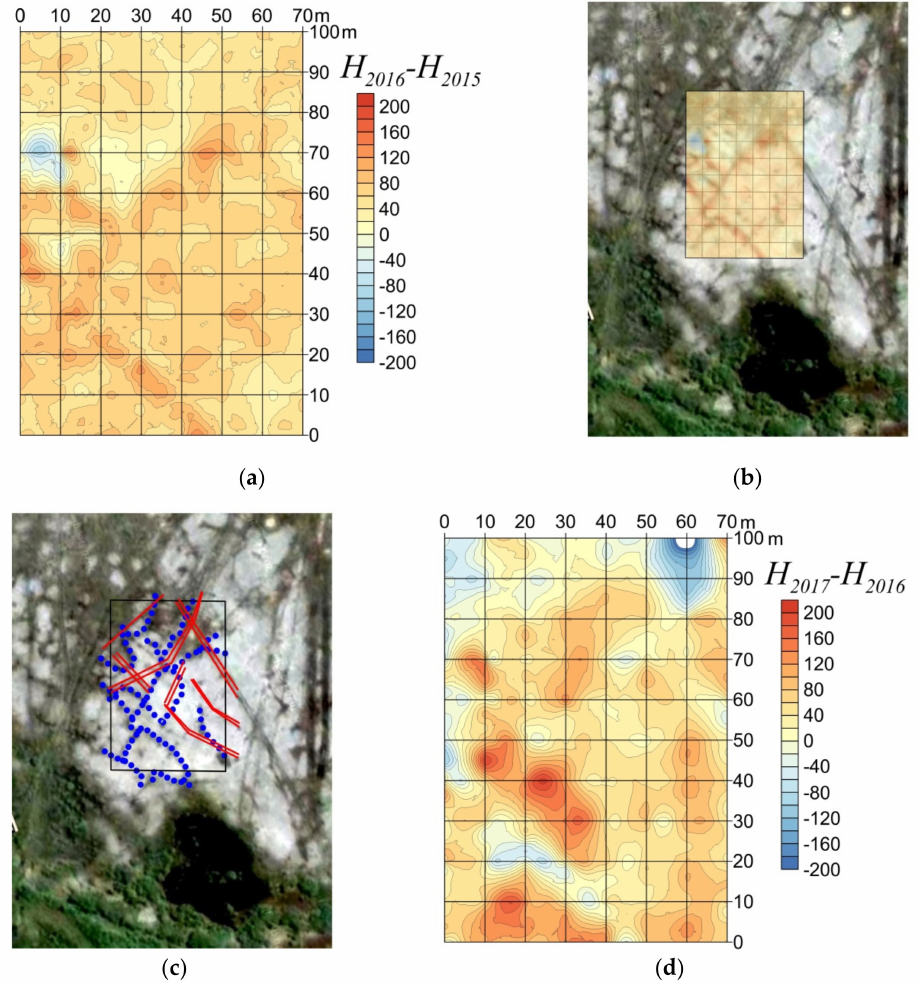
Figure 9. ( a ) The differences in the depth of the permafrost table at the Kumzha site (CALM R24A-2) in 2016–2015 according to GPR data, (b) the difference in the 2016–2015 map is overlaid on a satellite image, ( c ) satellite image with former roads (red) and natural polygonal structure borders (blue) highlighted, ( d ) difference in the depth of the permafrost table at the Kumzha site from 2017–2016 according to GPR